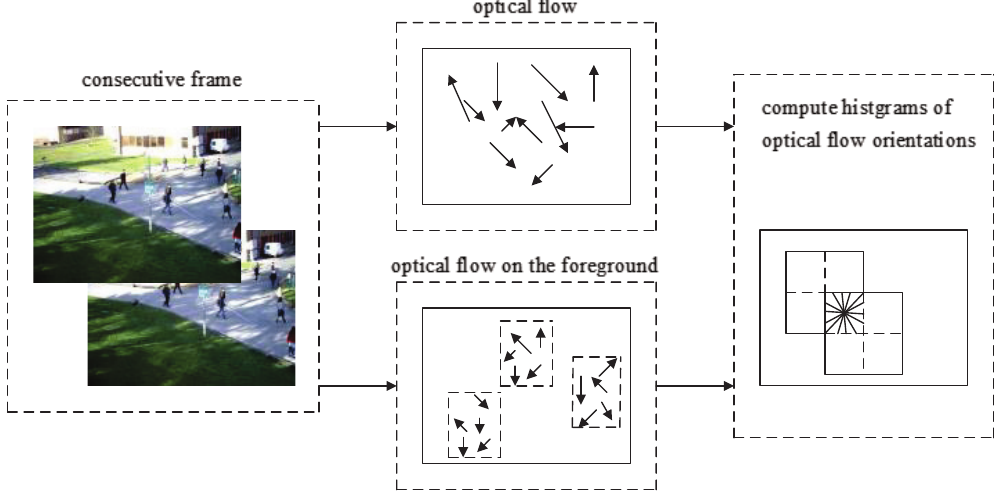
Figure 2. Histogram of the optical flow orientation (HOFO) feature descriptor on the original image or the foreground